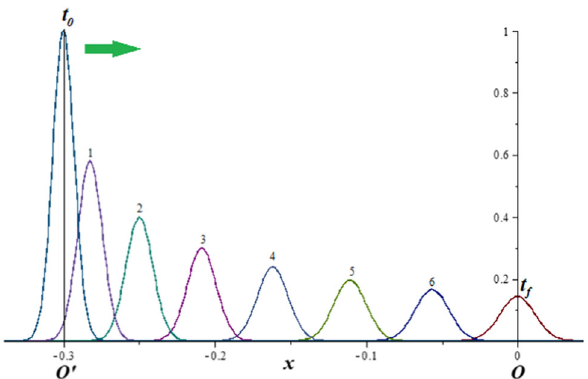
Fig. 1 Propagation of the wave packet with γ = 0 . 1 and ¯ k = 1000 in the space-time with s = 0 . 3 and r a ( t 0 ) = 1 . The packet is prepared in 3 O (cid:4) at the time t 0 = 0 . 1 and d = 0 . 3 < r a ( t 0 ) and measured in O at the time t f = 0 . 5034. We plot eight consecutive profiles of the maximum intensity I ( t , x ) between t 0 and t f at equal time intervals, Δ t = 0 .